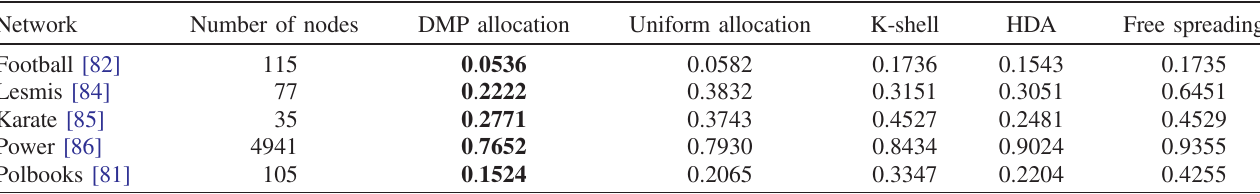
TABLE V. Comparing different resource-allocation approaches for collaborative processes on various networks. On each network, we randomly select 0 . 05 N nodes as seeds of process B and the same total budget for process A to be optimally allocated, where N is the total number of nodes in the network. The infection parameters chosen are α A ¼ 0 . 2 , α B ¼ 0 . 3 , α AB ¼ 0 . 4 , and α BA ¼ 0 . 5 . The initial parameter ϵ , which forces the budget limits per node as in Eq. (F2), is initially set to 0.1 but decays exponentially with the iteration steps. The optimization procedure is iterated 10 times, and the best result is selected. The objective function, in this case, is to maximize the P P i T Þ =N at time T ¼ 3 . In DMP allocation-based spreading of processes A and B , i.e., minimize the fraction of susceptible nodes i S ð optimization, we assume the seeding budget for B is available at time zero. Uniform allocation assumes that the budget for A is initially allocated uniformly to all free nodes. HDA deployment [83] and K-shell [64] seeding are used as before; in free spreading, no collaborative spreading budget A is allocated. The lowest fraction of susceptible nodes is denoted by bold.